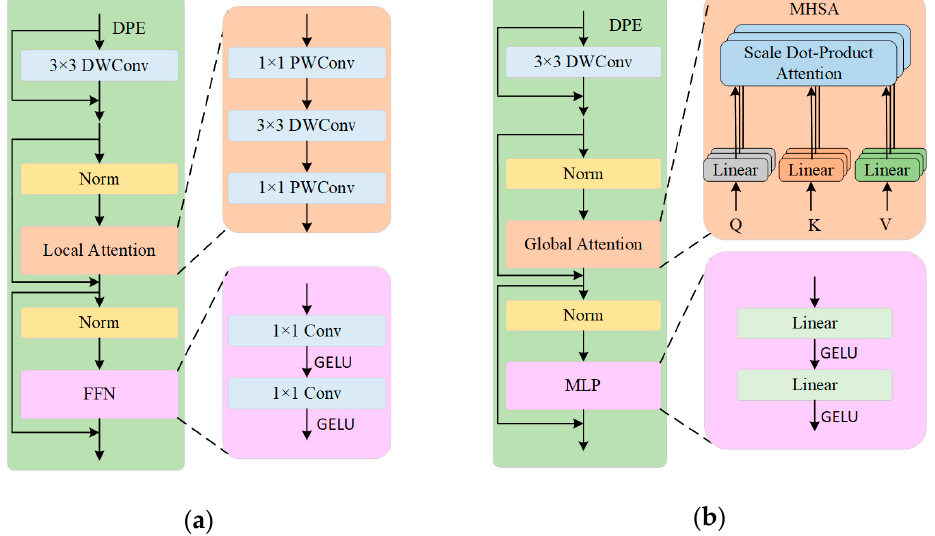
Figure 4. The network structure of the Convolution Block and the Transformer Block. ( a ) Convolution Block and ( b ) Transformer Block.